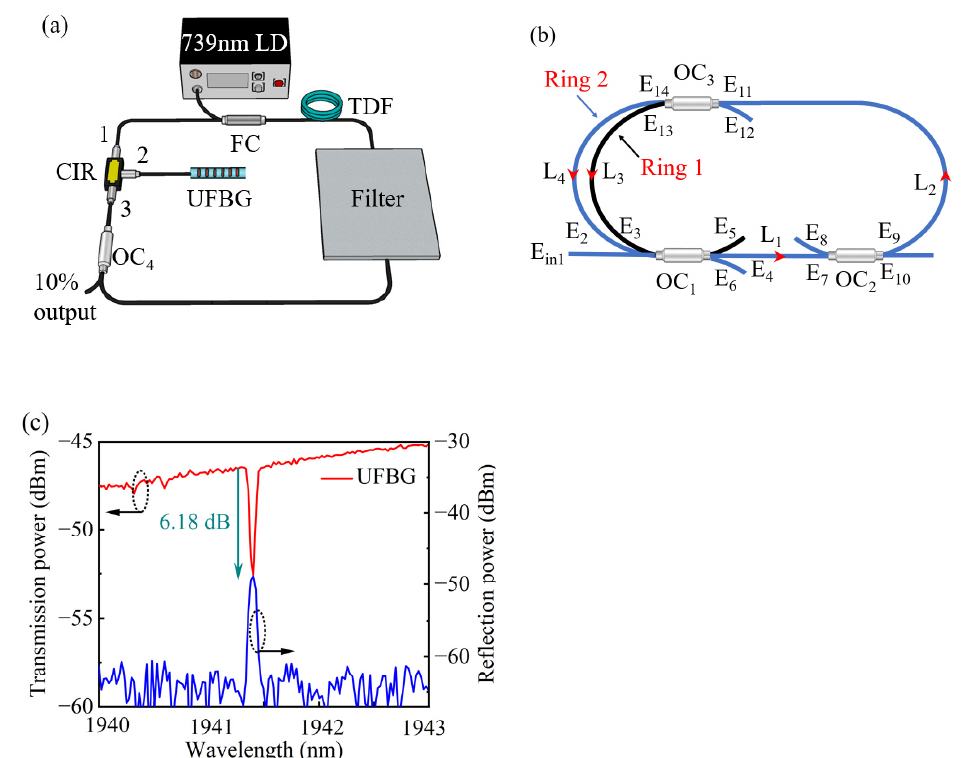
Figure 1. ( a ) Schematic of proposed fiber laser. LD: laser diode; FC: fiber combiner; TDF: thulium- doped fiber; CIR: circulator; UFBG: uniform fiber Bragg grating; OC: optical coupler. ( b ) Schematic diagram of the TCR-CC filter. Ring 1 is composed of L 1 , L 2 , L 3 . Ring 2 is composed of L 1 , L 2 , L 4 . ( c ) Transmission and reflection spectra of the UFBG.